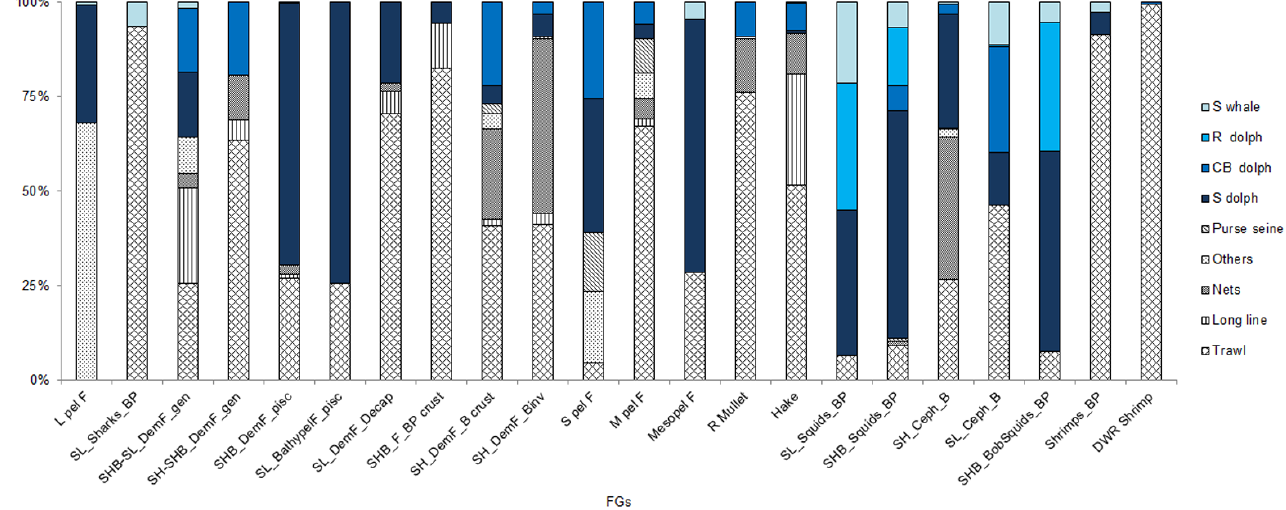
Figure 6. Comparison between odontocetes’ feeding and fishery catches (expressed in %) by FGs estimated by the food web model in GoT. Blue shading corresponds to the FGs of odontocetes and the pattern fill represents different types of fishing gear.